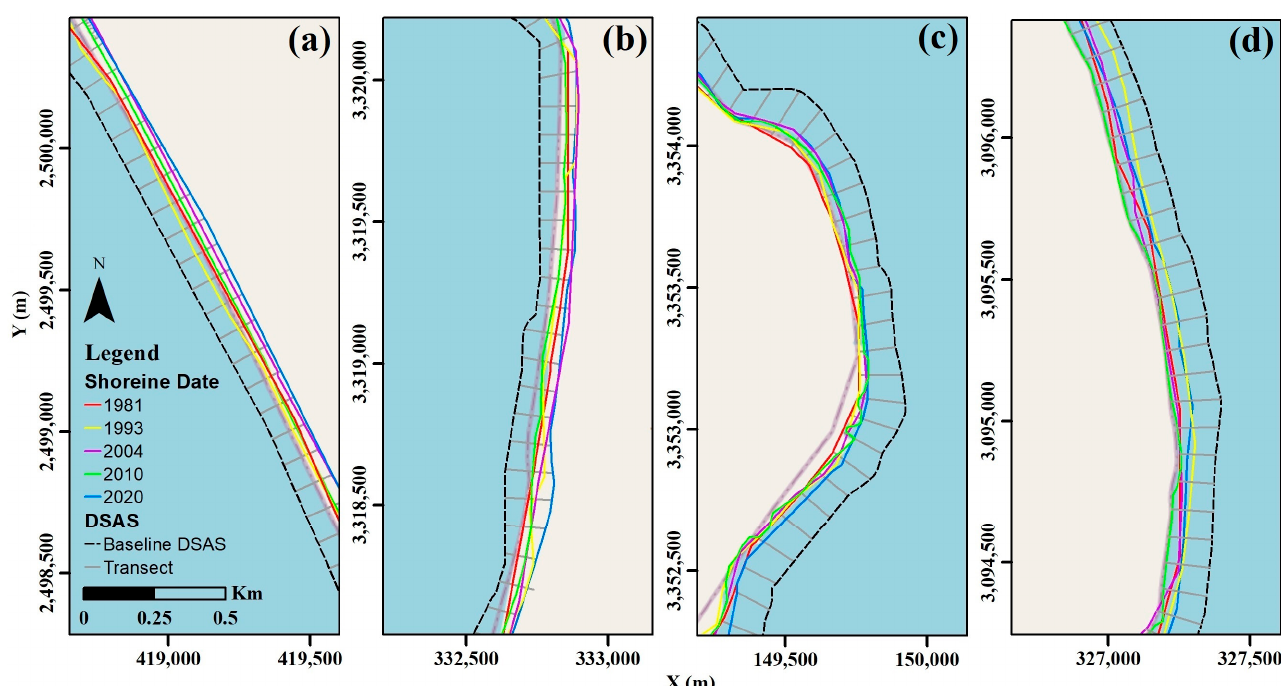
Figure 4. Shoreline: ( a ) Sinaloa, ( b ) Sonora, ( c ) Baja California, and ( d ) Baja California Sur.